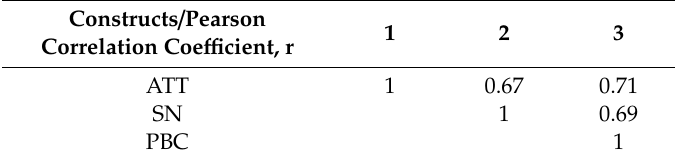
Note: all correlation coe ffi cients were statistically significant at p <